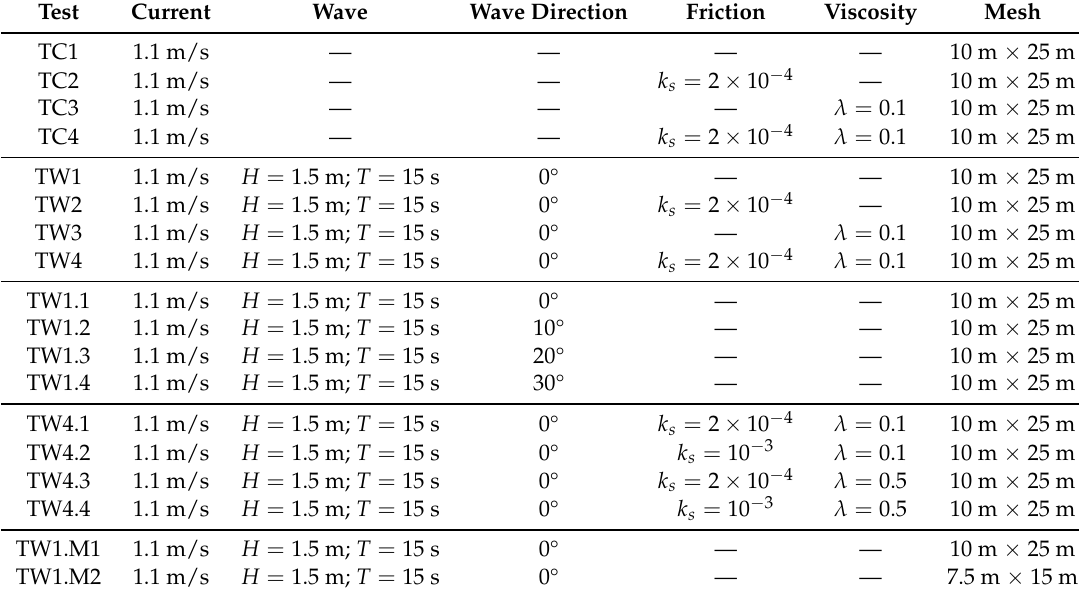
Table 1. Summary of the performed numerical